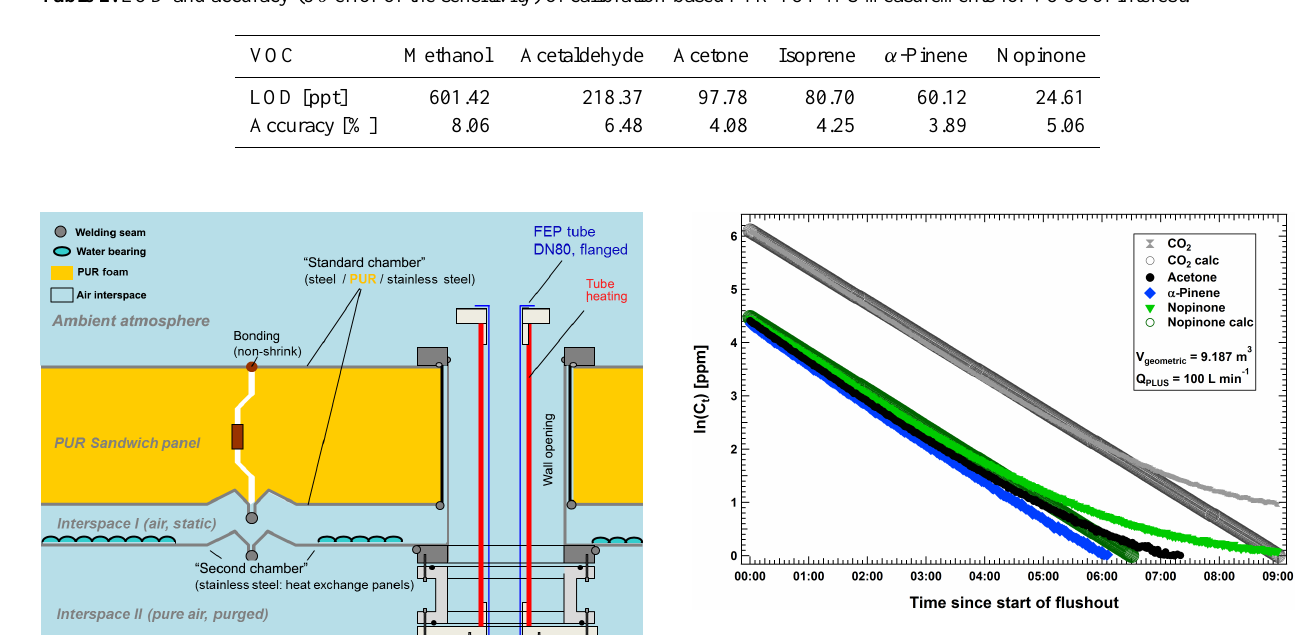
Figure 3. CO 2 and VOC flush out characteristic inside the PLUS gas exchange